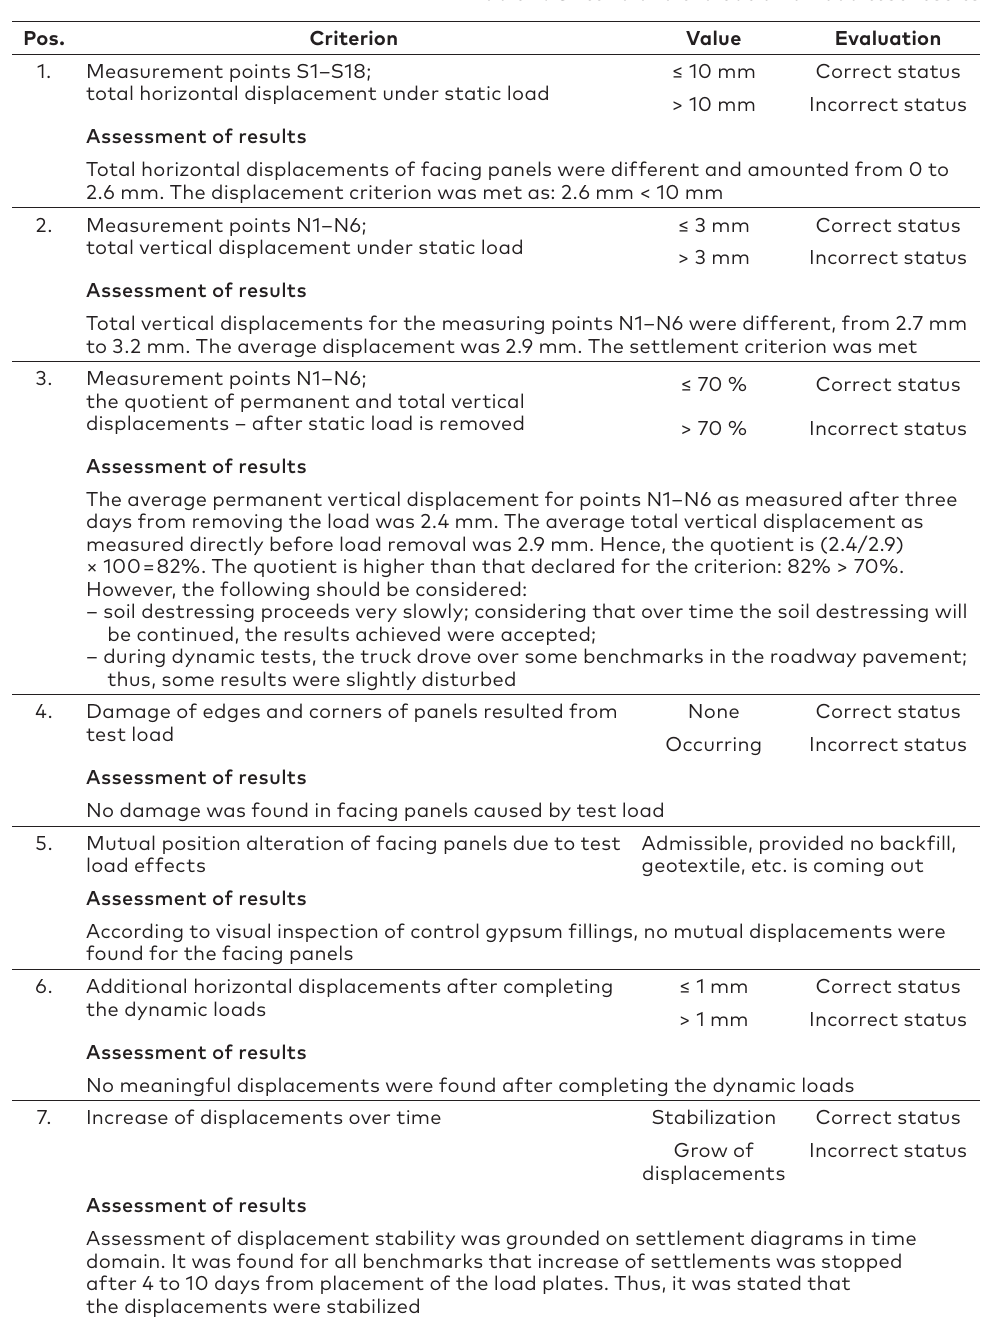
Table 4. Criteria and evaluation of load test